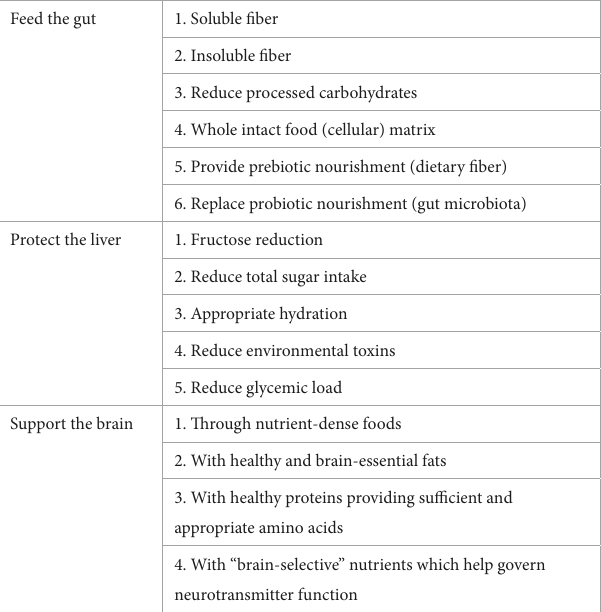
TABLE 1 Rationale and strategies of the Metabolic Matrix to improve